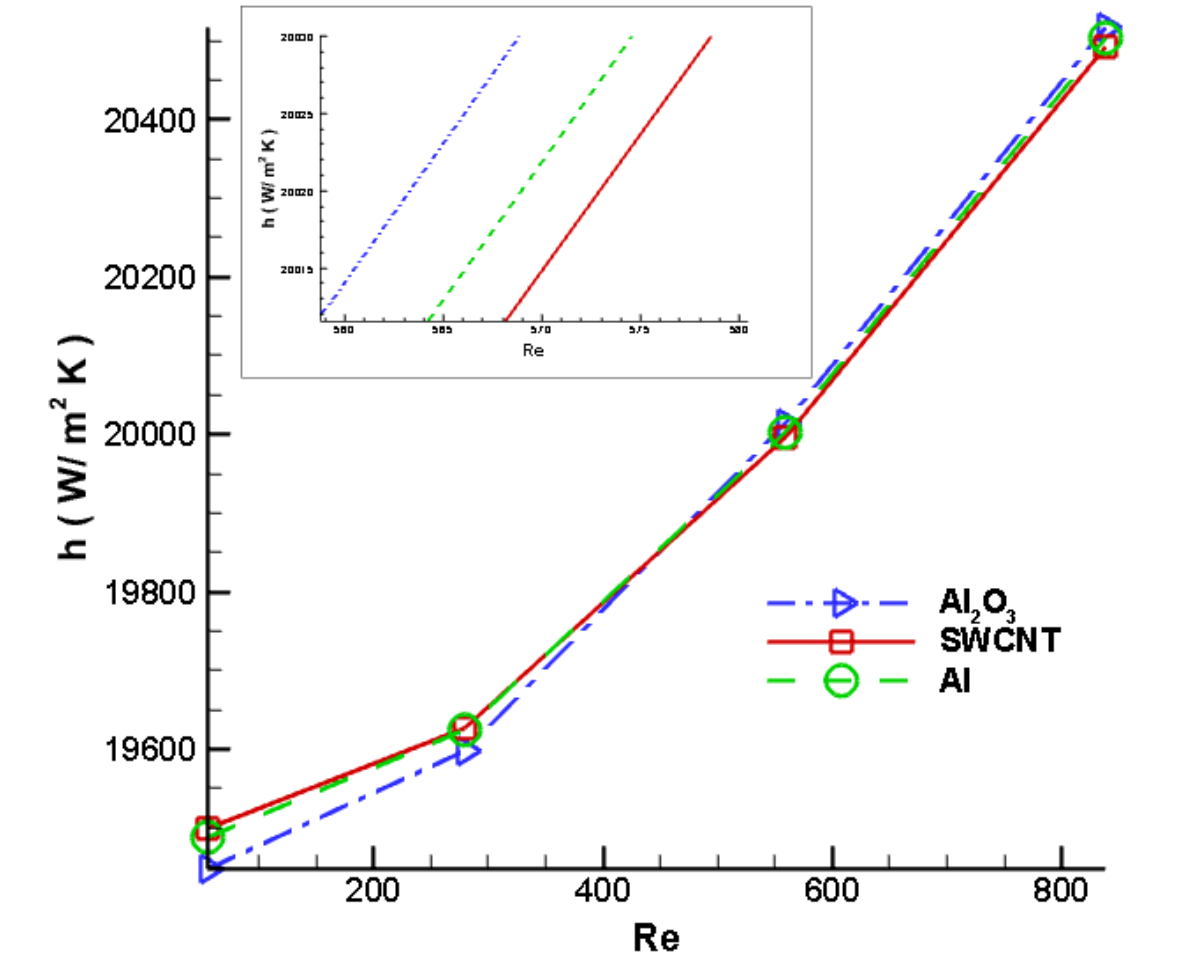
Figure 16. Variation in convective heat transfer coefficient of the cutting tool with respect to Reynolds number.